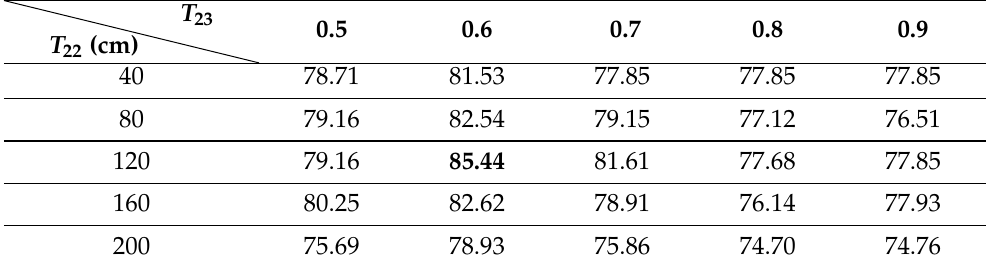
Table 2. NMI (%) corresponding to different sets of key parameters.